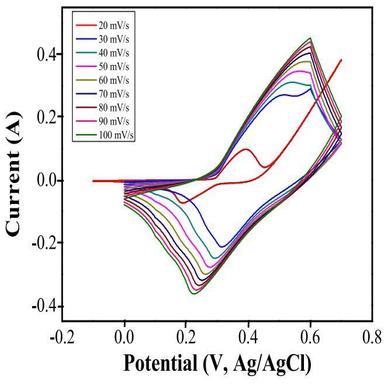
CV curves of MoS2 film at different scan rates.